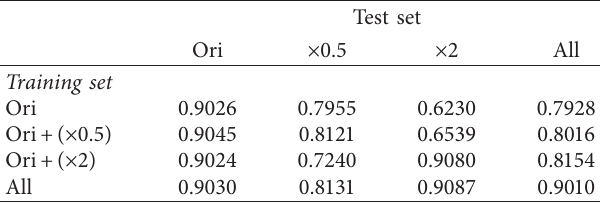
Table 4: Test results before and after scaling.